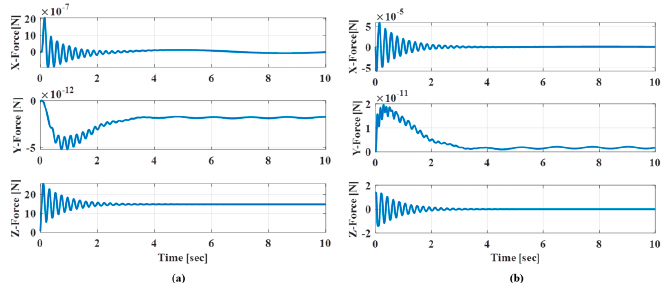
Figure 18. Forces by underwater cable when stationary motion: ( a ) Force acting on the UUV; ( b ) Force acting on the USV.